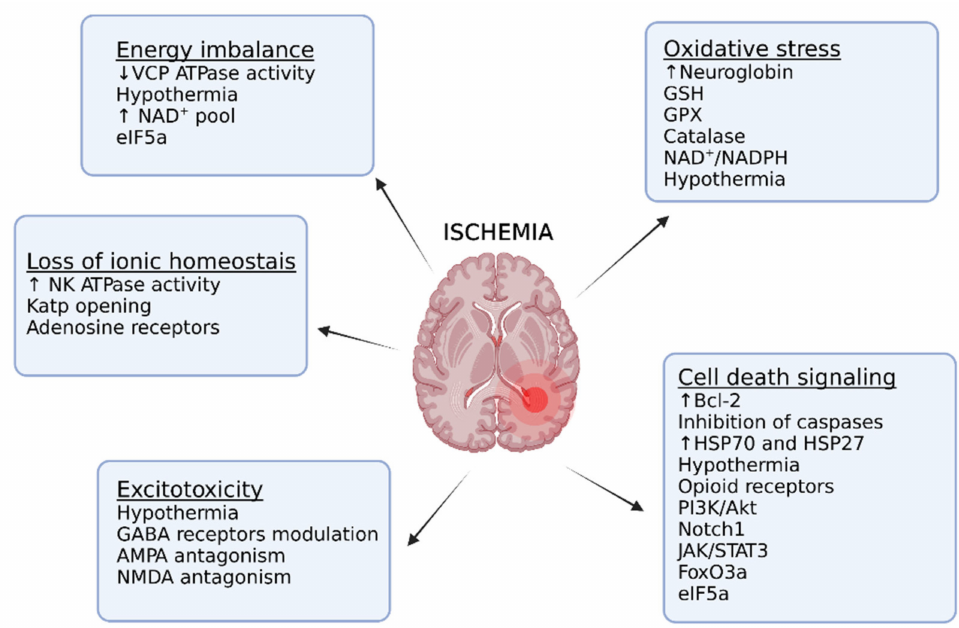
Figure 3. Mechanisms involved in hypoxia tolerance of translational potential for stroke treatment. Abbreviations: VCP ATPase: valosin-containing protein (VCP) ATPase; NAD + :nicotinamide adenine dinucleotide; eIF5A: eukaryotic initiation factor 5A: N/K ATPase: Na + /K + -ATPase; Katp channel: ATP sensitive potassium channel; GABA: Gamma aminobutyric acid; NMDA : N-methyl- D -aspartate; GSH: glutathione; GPx: glutathione peroxidase; NADP: Nicotinamide adenine dinucleotide phosphate; Bcl-2: B-cell lymphoma; HSP: heat shock protein: PI3K: Phosphoinositide 3-kinase; Akt: protein kinase B; Notch1: Neurogenic locus notch homolog protein 1; JAK: Janus kinase; STAT3: signal transducer and activator of transcription 3; FoxO3a Forkhead Box